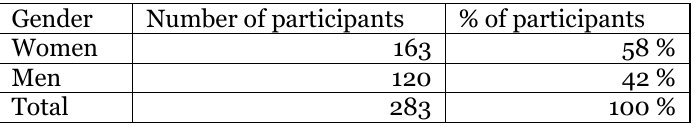
Population Distributed by Gender Gender Number of participants % of participants Women 163 58 % Men 120 42 %